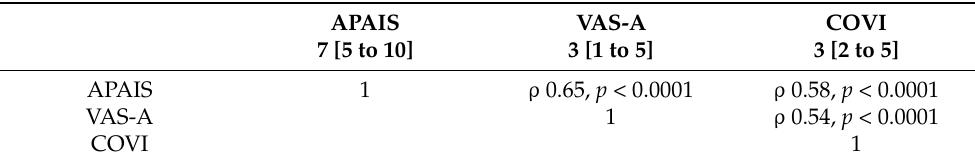
Table 1. Results of anxiety level measurements in patients upon TWA arrival and correlation between measurement instruments. APAIS VAS-A COVI 7 [5 to 10] 3 [1 to 5] 3 [2 to 5] APAIS 1 ρ 0.65, p < 0.0001 ρ 0.58, p < 0.0001 VAS-A 1 ρ 0.54, p < 0.0001 COVI 1 Measurement values for anxiety are presented as median and [interquartile range]. TWA, transfer and waiting area; APAIS, Amsterdam preoperative anxiety and information scale; COVI, Covi’s anxiety scale. Data shown as medians [interquartile range], and Spearman’s